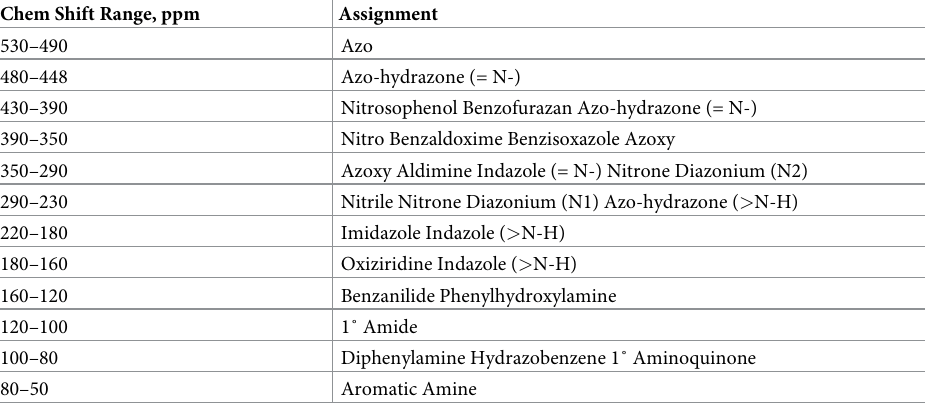
Table 3. Assignments for N-15 NMR